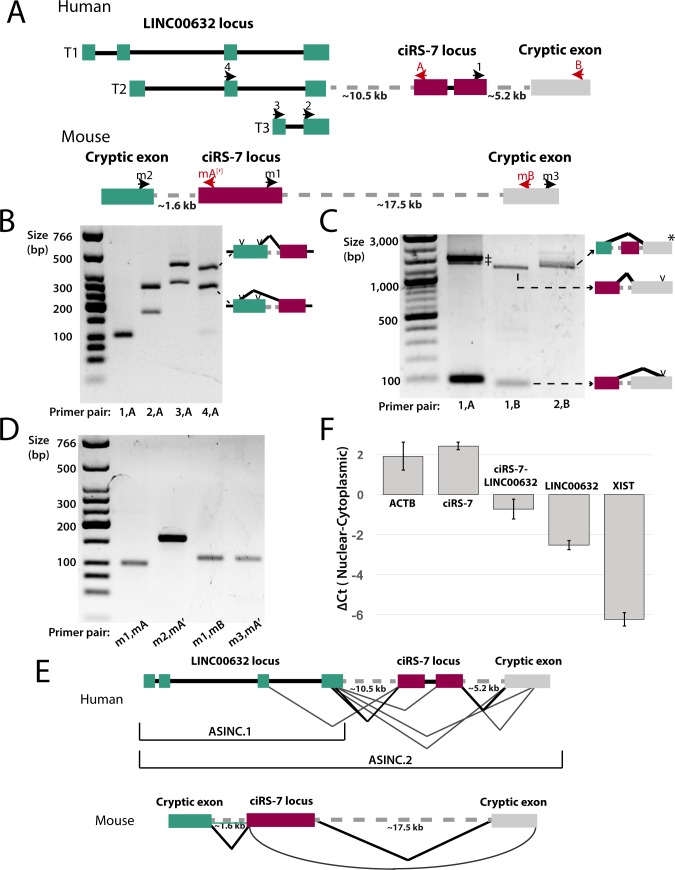
ciRS-7 exonic sequence is included in linear transcripts.(A) Schematic of the locus including PCR primers used in this study. Dotted lines indicate approximate positions of newly discovered introns. Figure is not drawn to scale. (B) RT-PCR of circular and linear ciRS-7 splice products from HEK293T. (1,A): control PCR for ciRS-7; other lanes: LINC00632 exons spliced to the ciRS-7 exonic sequence: the two bands in each of these lanes represent the products formed when the two possible splice sites in the final exon of LINC00632 are used (see diagram on the right of gel). (C) PCR of spliced products that include cryptic exons downstream of ciRS-7. (‡) represents rolling circle ciRS-7 PCR products with and without intron retention. (*) Other products were also identified (see S7 Fig). (D) RT-PCR of circular and linear ciRS-7 splice products from mouse brain RNA. mA and mA’ bind to approximately the same region but have slightly different sequence (see S1 File). (E) Examples of novel splicing observed in the human and mouse ASINC loci. Curved line in mouse indicates a backsplice. (F) qPCR quantification of nuclear-cytoplasmic fractionated RNA from HEK293T. Error bars represent the standard deviation of biological replicates.